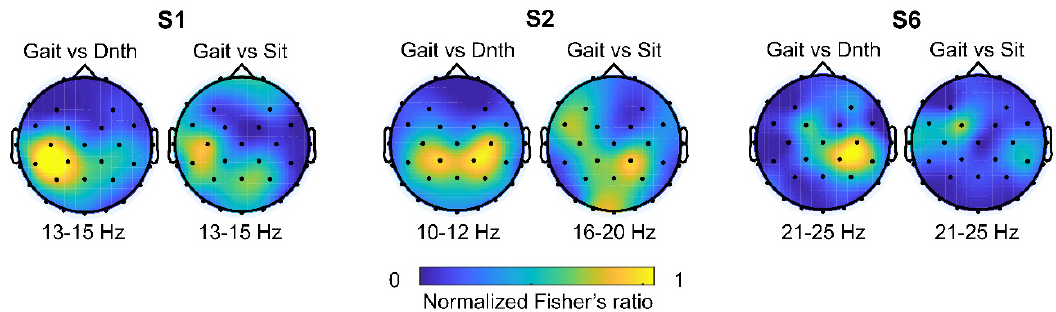
Figure 7. A topography of normalized Fisher ratio between Gait MI(Gait) vs. Do-nothing (Dnth) and Gait MI vs. Sit MI(Sit). Repeated trials of signal power in each frequency band were averaged to calculate the fisher ratio. The most dominant frequency band and electrode channels were visually illustrated and highlighted in yellow color. Three out of ten subjects’ topography were representatively showed to demonstrate a distinct desynchronization area.